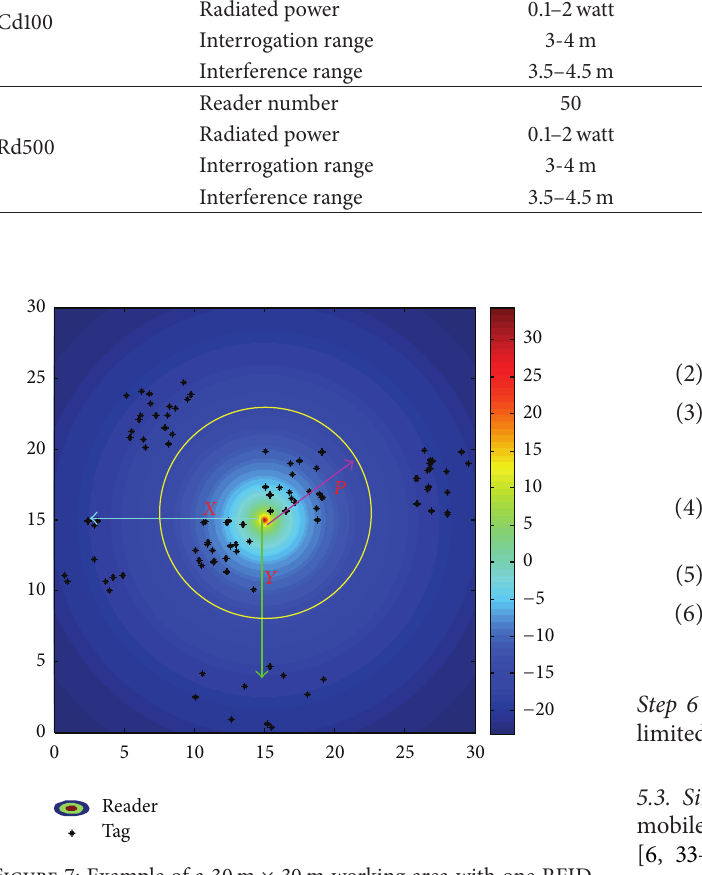
Figure 7: Example of a 30 m × 30 m working area with one RFID reader and 100 tags. The radiated power level (dBm) marked on the right diagram sidebar and the yellow cycle represents the read range of the RFID